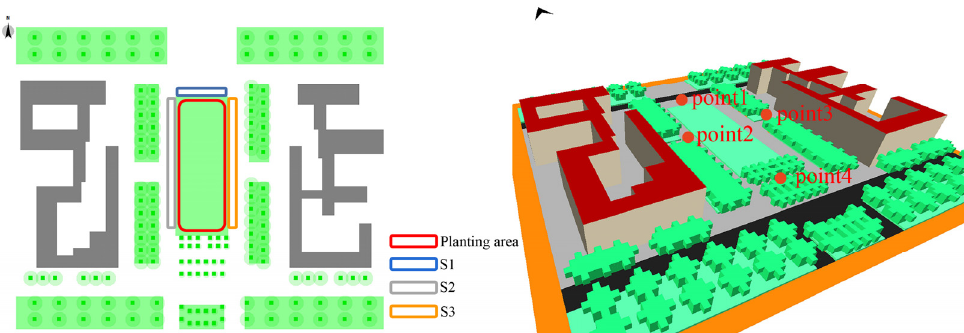
Figure 5. The ENVI-met model of the base case. Table 4. Boundary conditions for the ENVI-met model.